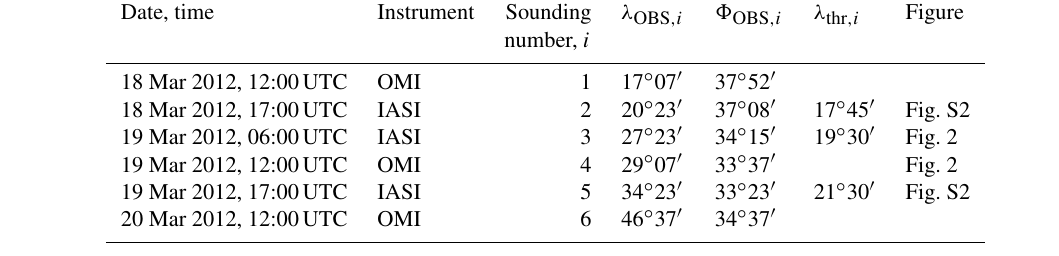
Table 3. IASI and OMI soundings list. λ OBS ,i (longitude) and (cid:56) OBS ,i (latitude) represent the plume’s column with the highest SO 2 content coordinates. λ thr ,i is the limit longitude that has been set as limit between the eastern and western plumes in Sect. 3.5.